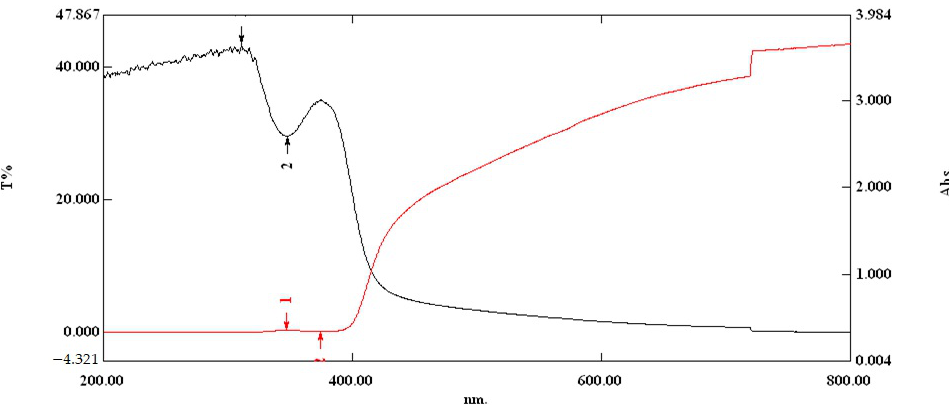
Figure 7. The absorption and transmission spectra of the optimal sample (200-800